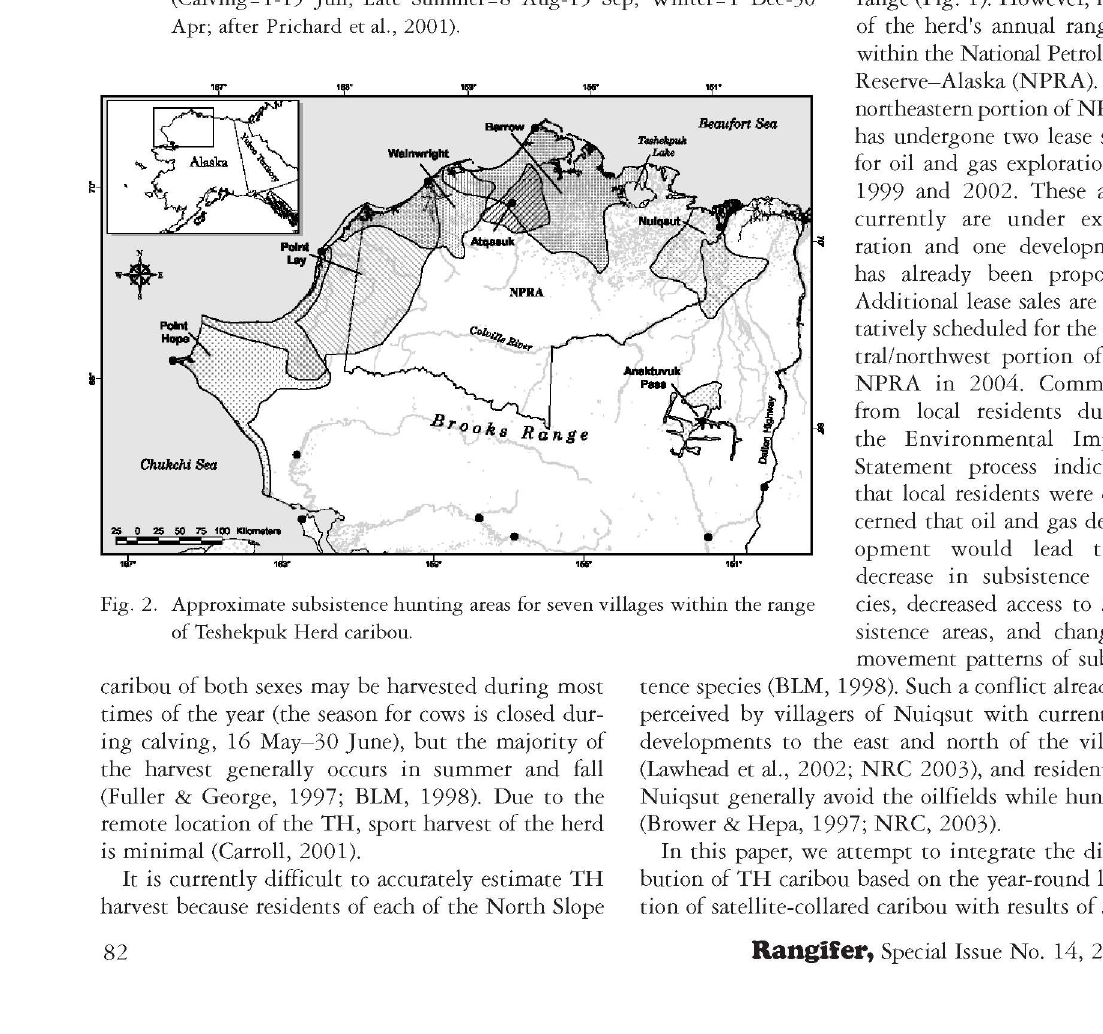
Fig. 1. Seasonal range of Teshekpuk Herd caribou based on satellite collar loca¬ tions 1990—1999. Ranges represent 95% utilization distributions based on fixed-kernel analysis of one location per transmitting day (Calving=1-15 Jun; Late Summer=8 Aug-15 Sep; Winter=1 Dec-30 Apr; after Prichard et al., 2001).